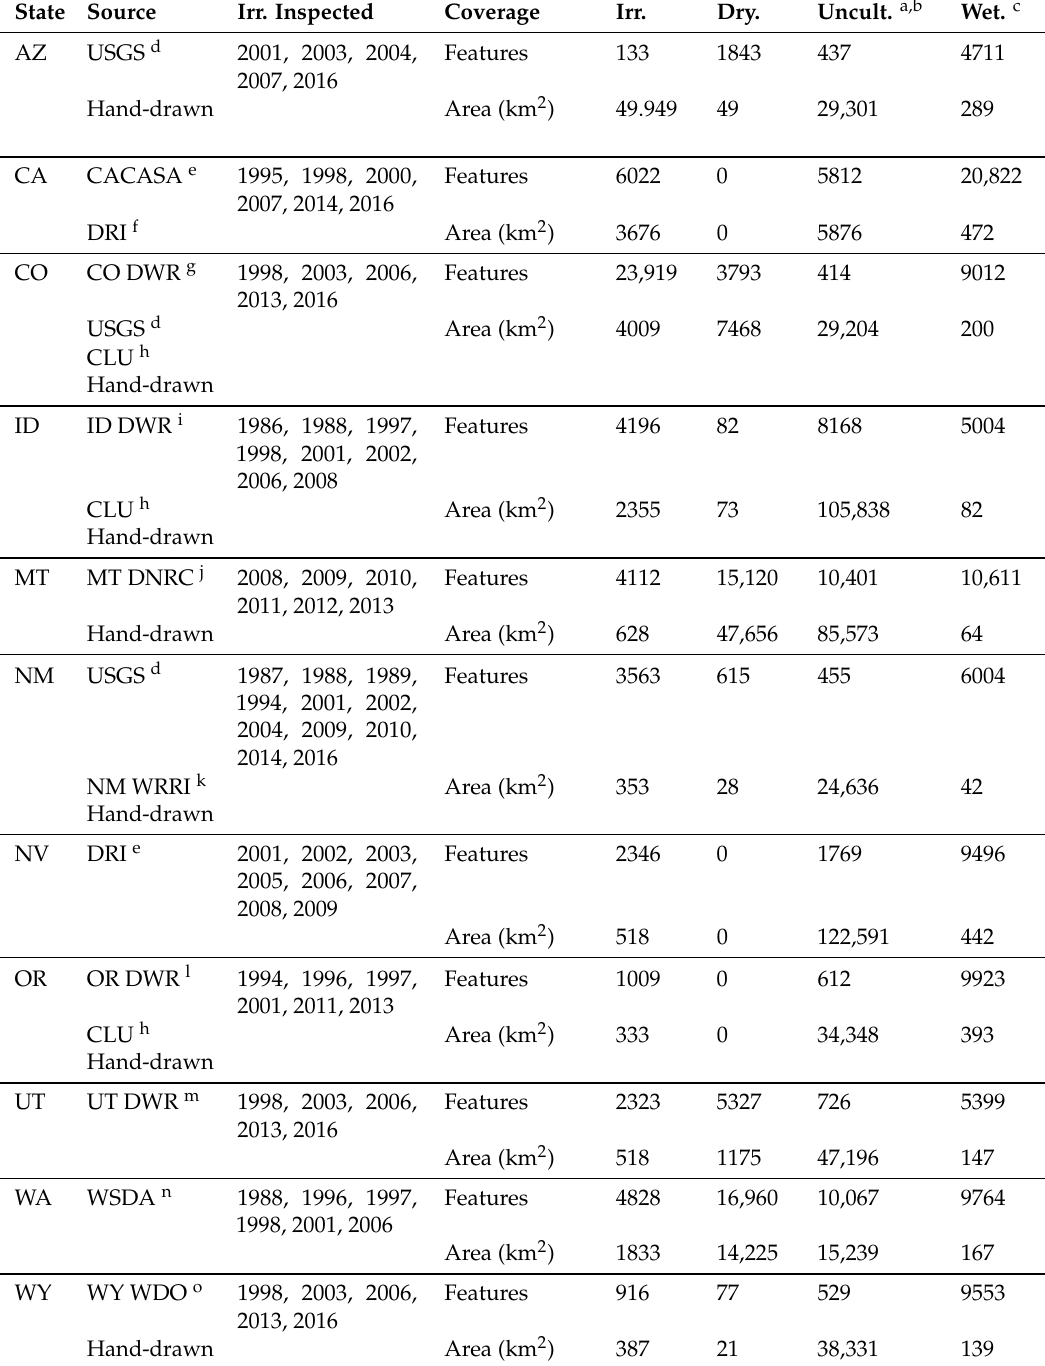
Table 1. Summary of geospatial training data by